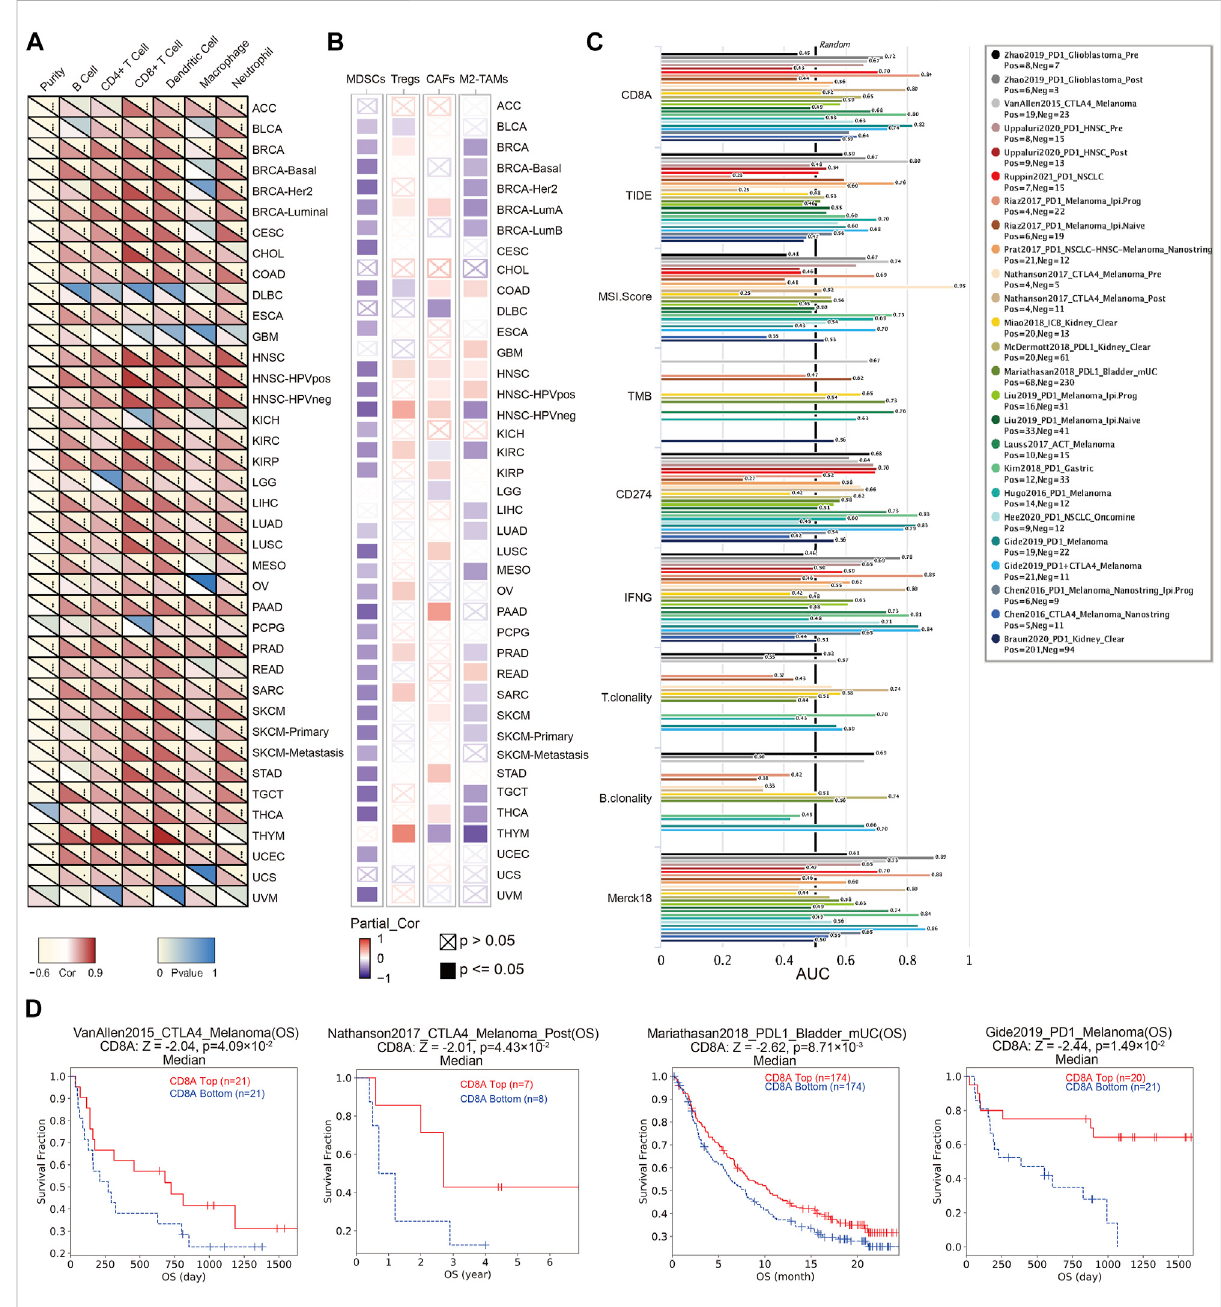
FIGURE 4 TheroleofCD8AinTME,anditspotentialinpredictingthetreatmentresponsesofimmunotherapy (A) Heatmapshowingcorrelationsbetween CD8A expression with six major immune cell types in the pan-cancer datasets based on TIMER2 server (B) Heatmap showing correlations between CD8A expression with four immunosuppressive cell in the pan-cancer datasets based on TIMER2 server (C) Bar plot presenting the predictive ability of CD8A for immunotherapy ef fi cacy compared with other canonical biomarker signatures, based on treatment response, and prognosis of varying cancer cohorts treated with immune checkpoint blockade (ICB) in TIDE database (D) Correlation between CD8A expression and survival outcome of cancer cohorts treated with ICB, as well as its associations with cytotoxic T lymphocytes (CTL)